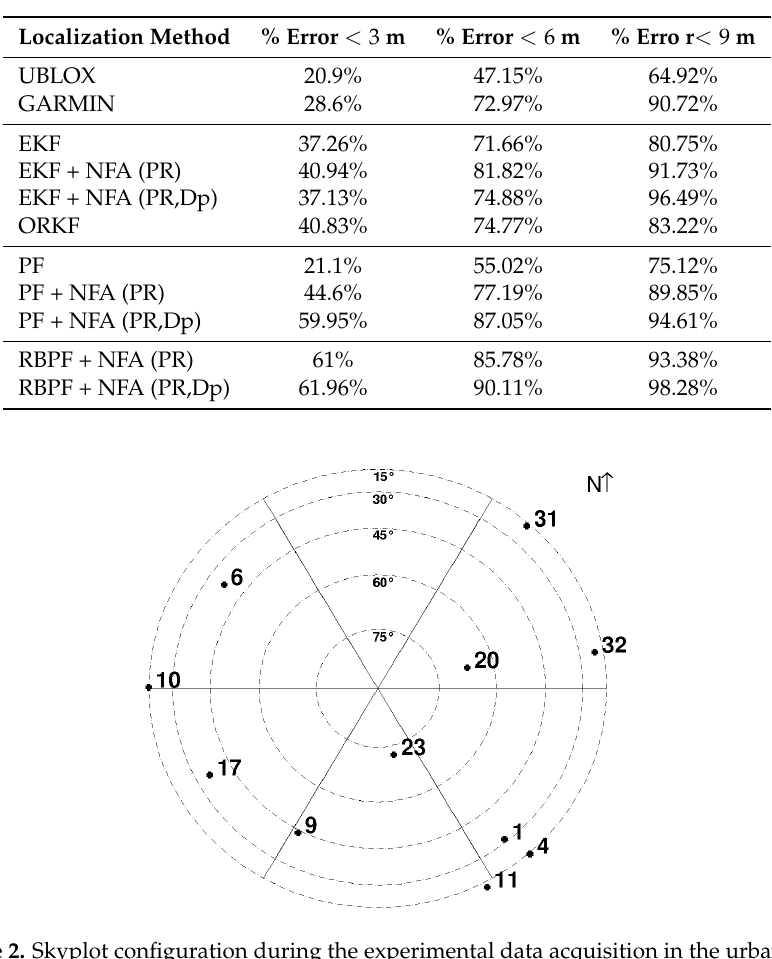
Table 1. Percentiles of positioning errors. NFA, Number of False Alarms; PR, Pseudo-Range; Dp, Doppler measurement; RBPF, Rao–Blackwell Particle Filter; ORKF, Outlier Robust Kalman Filter.